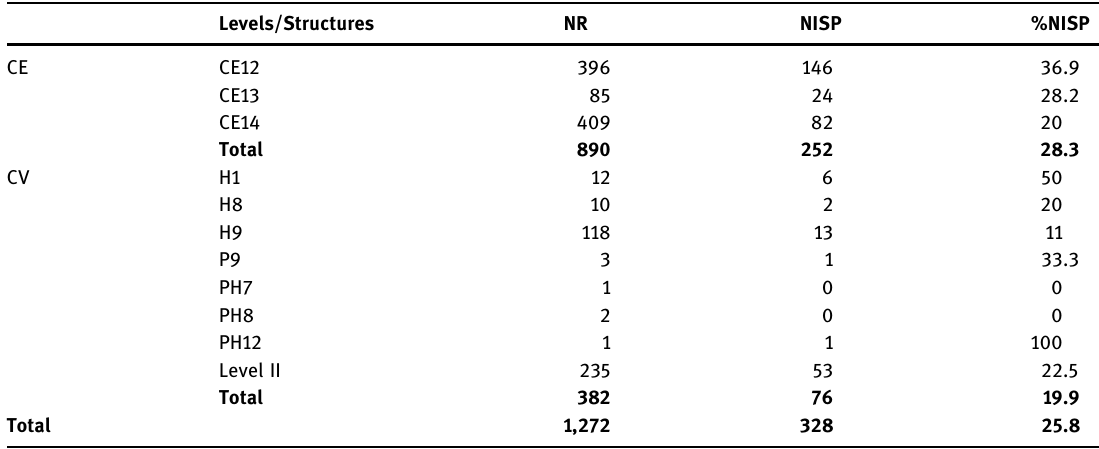
Table 1: Distribution of the number of faunal remains ( NR ) , the number of identi fi ed specimens ( NISP ) , and the percentage of NISP ( %NISP ) in relation to the total sample, by level and stratigraphic unit